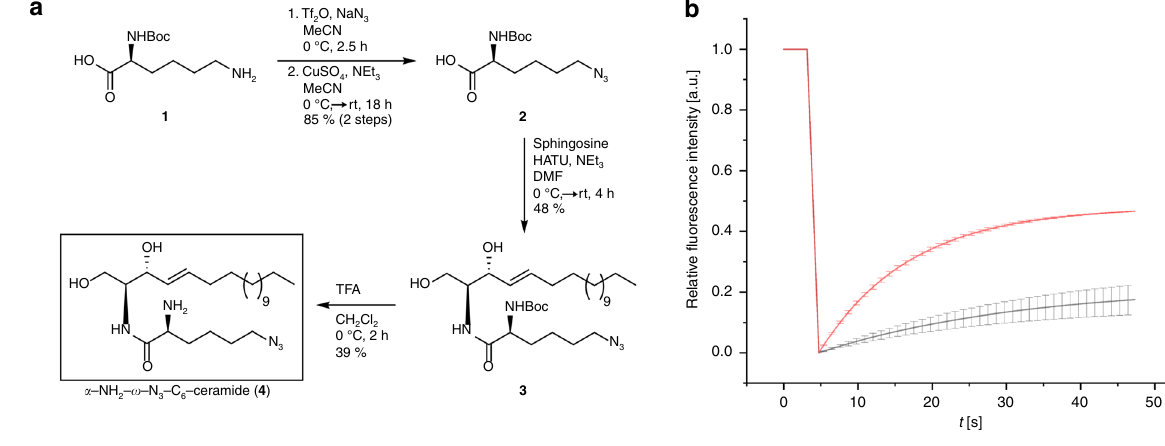
lipid tail on the amine terminus of the lysine chain, with a glycine in between to provide mechanical fl exibility. Furthermore, a biotin residue is attached to enable fl uorescence staining of the probe with labeled streptavidin. Alternatively, a trifunctional linker strategy termed TRITON has been introduced for ExM that enables simultaneous targeting, labeling, and grafting of biomolecules using a monomer unit (acryloyl) into the hydro- gel 26 . Using 1,2-distearoyl- sn -glycero-3-phosphoethanolamine (DSPE) as small-molecule targeting staining phospholipid bilay- ers, cellular membranes can be expanded and imaged. All these alternative methods can be used as well for joint imaging of proteins and lipid membrane structures at nanoscale resolution.